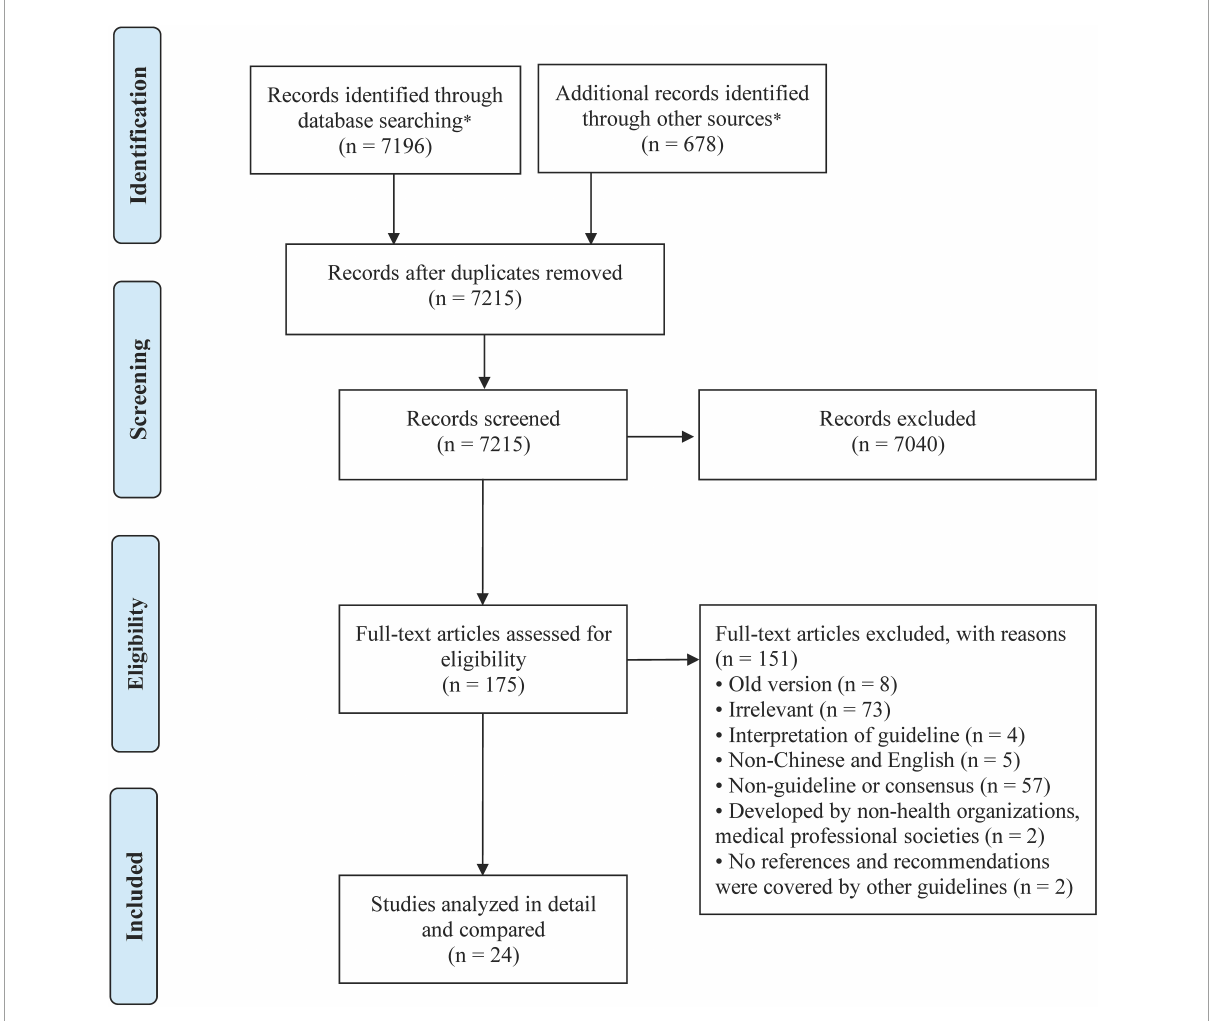
FIGURE1 Preferred reporting items for systematic reviews and meta-analyses (PRISMA) diagram for the included studies. ∗ The specific databases searched and the number of literatures detected are as follows: PubMed ( n = 549), Embase ( n = 4,371), CNKI ( n = 1,019), WangFang ( n = 766), SinoMed ( n = 491), AHRQ ( n = 79), GIN ( n = 16), NICE ( n = 245), SIGN ( n = 0), IPGRP ( n = 19), WHO ( n = 11), AAP ( n = 146), ASN ( n = 50), FENS ( n = 107), hand search for relevant references ( n =